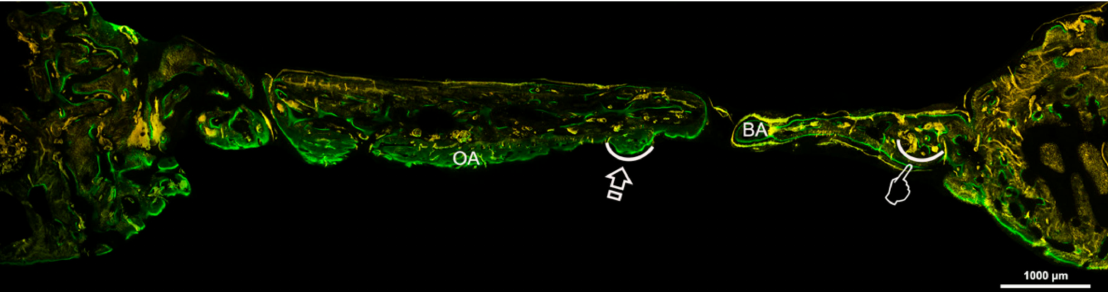
Figure 11. Bone histology obtained by fluorescence with calcein at the region of interest to see mineralized bone, at six weeks of healing time after using Zn-loaded membranes. Pointers indicate bone perimeter and arrows signal osteoid perimeter. Bone area (BA), Osteoid area